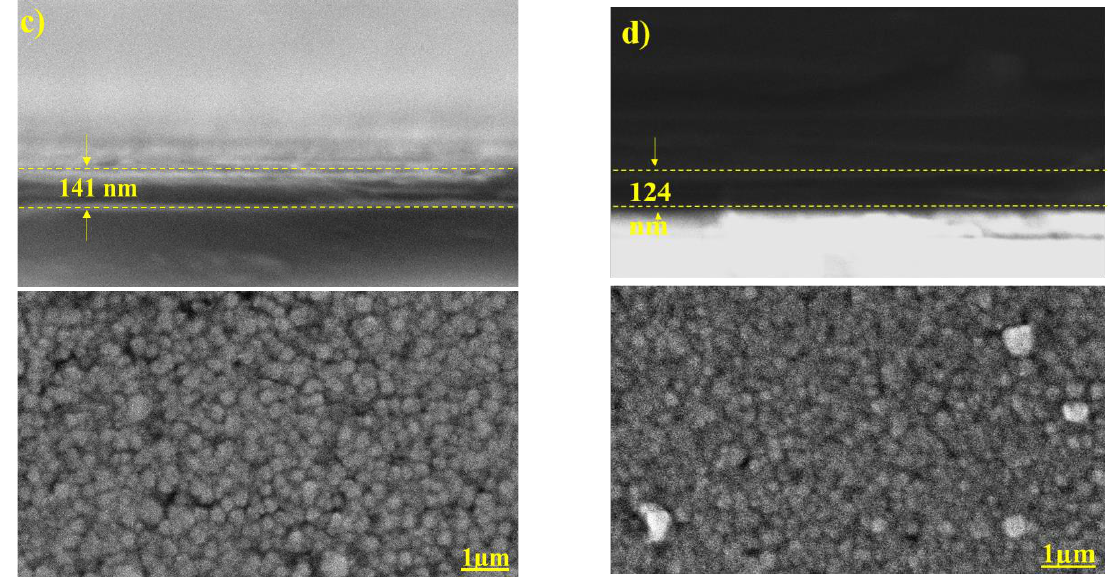
Figure 7. SEM micrograph of CdS thin film at; ( a ) [1/0.75], ( b ) [1/1], ( c ) [1/5], ( d ) [1/25].